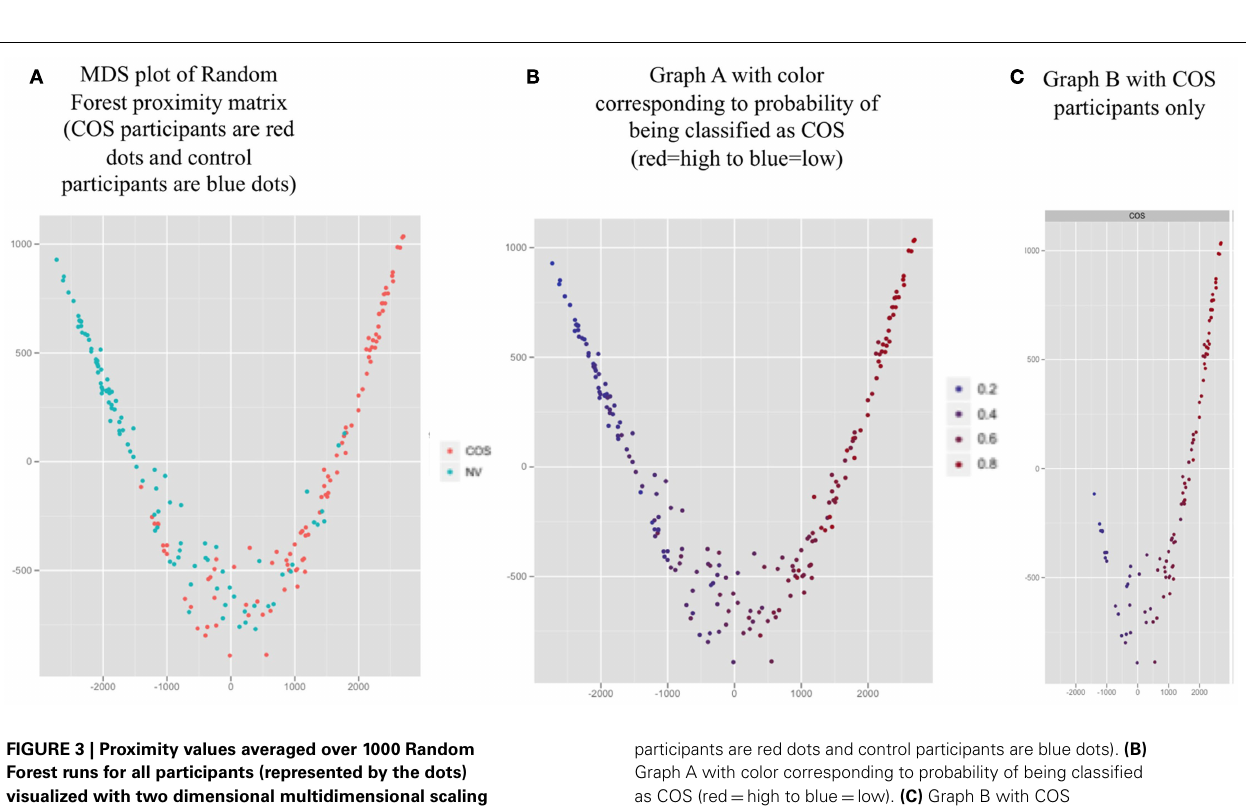
participants are red dots and control participants are blue dots). (B) Graph A with color corresponding to probability of being classified as COS (red = high to blue = low). (C) Graph B with COS participants only.